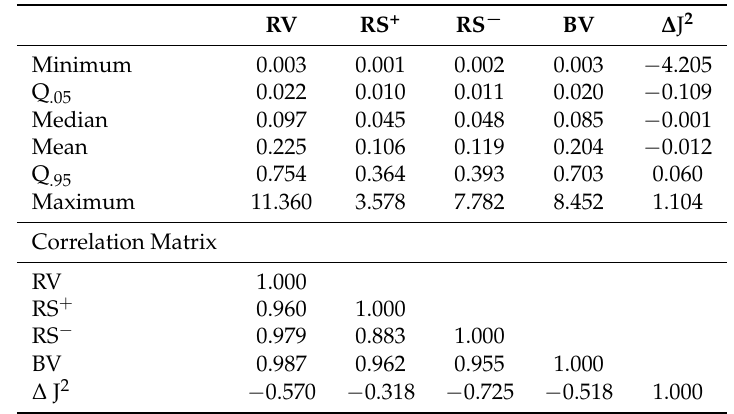
Table 1. Summary statistics.